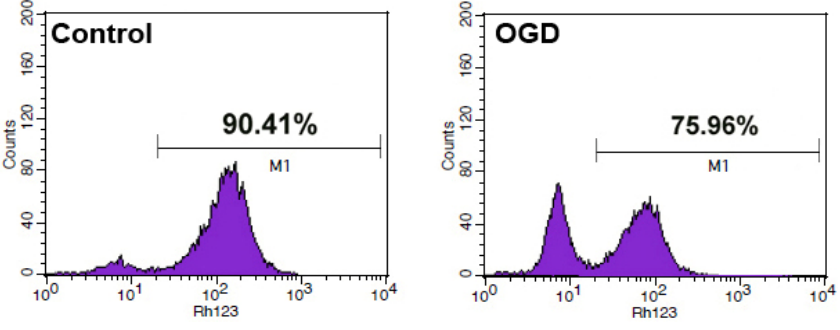
Figure 4. Measurement of mitochondrial membrane potential by flow cytometry. Treatment with 1.0 µmol/L or 10.0 µmol/L GRb1 counteracted OGD-induced reduction of mitochondrial membrane potential in SH-SY5Y cells. This result indicated that